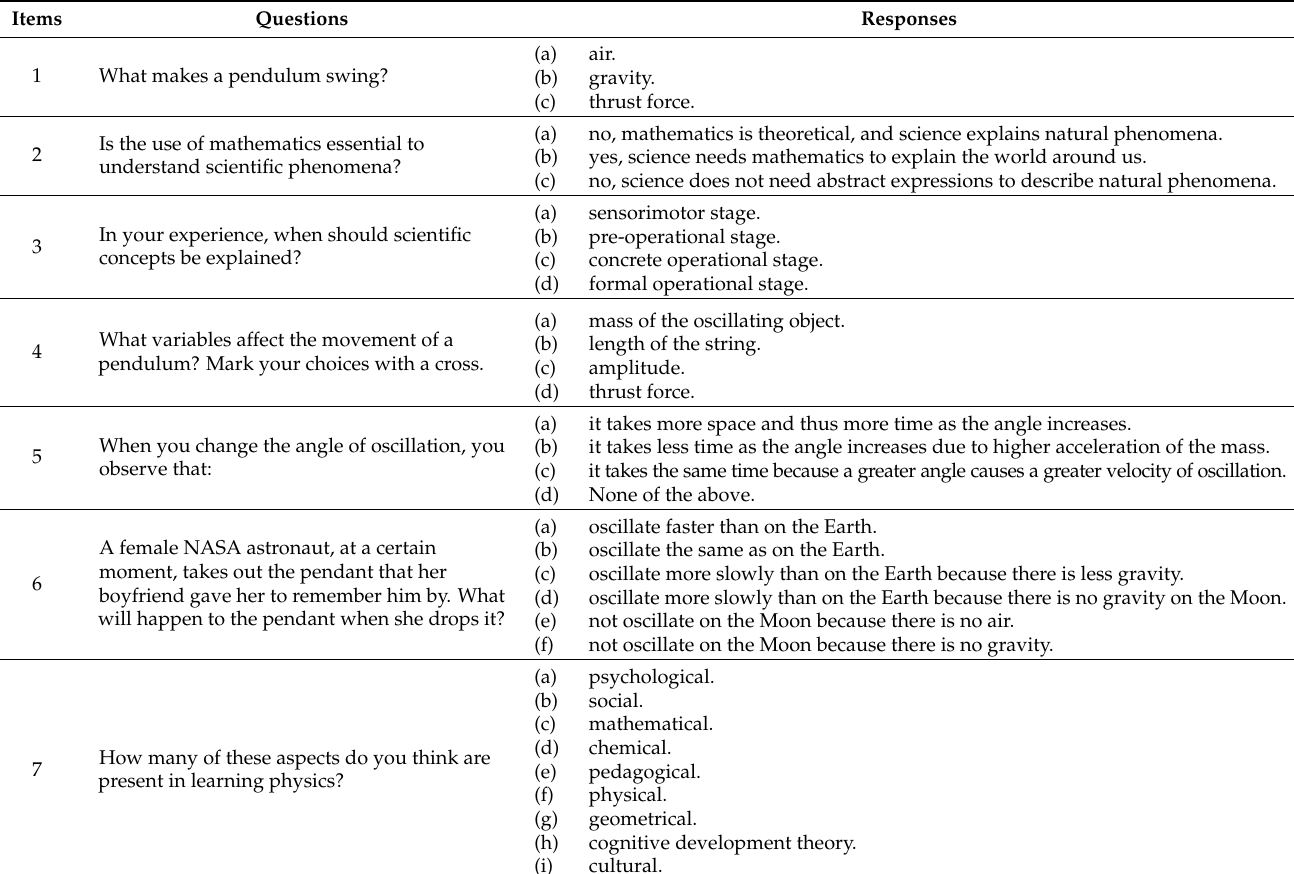
Table 1. Instrument for testing the neurodidactic sessions (pre-test and